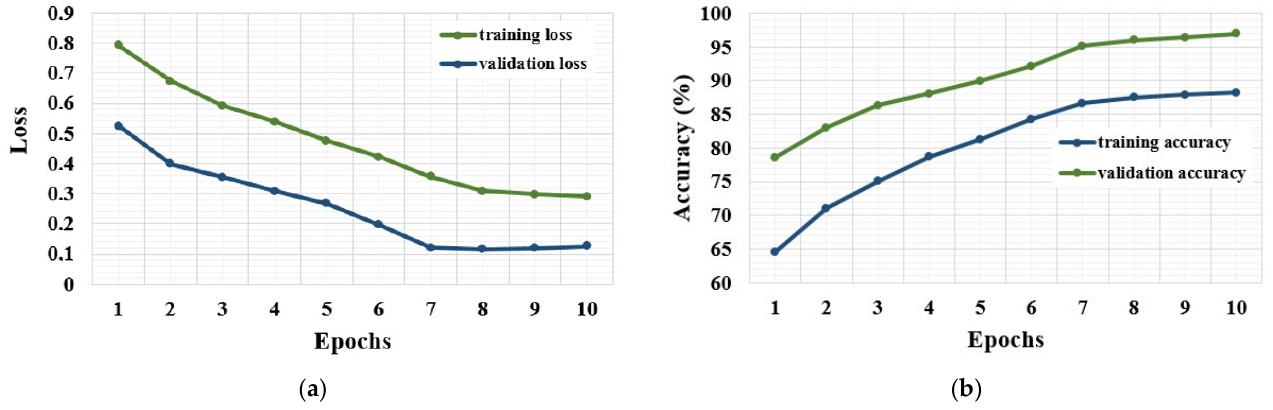
Figure 16. The performance metrics for 20°/20° tooth pro fi le and SNR 15: ( a ) loss-versus-epochs; ( b ) accuracy-versus-epochs graphs.